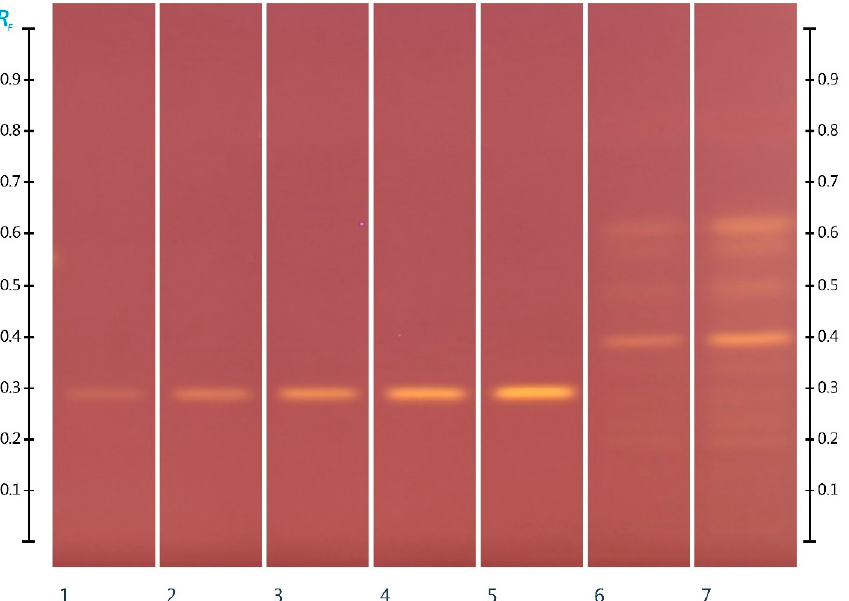
Figure 6. HPTLC images taken at transmission white (T white) light at 60 min after derivatization with 0.4% DPPH reagent; Track 1–5—Gallic acid (Rf 0.29) 2 µL, 3 µL, 4 µL, 5 µL, and 6 µL standards in methanol; Track 6—5 µL, and Track 7—10 µL ant honey extract .